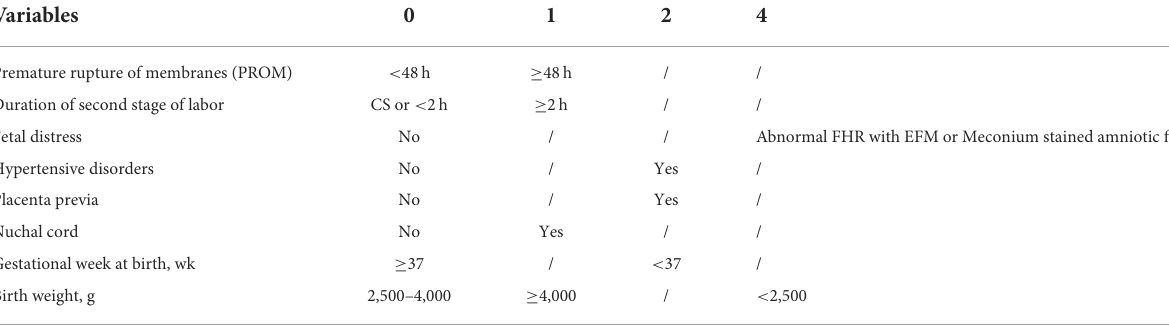
TABLE 5 A clinical characteristics scoring system for predicting NA.